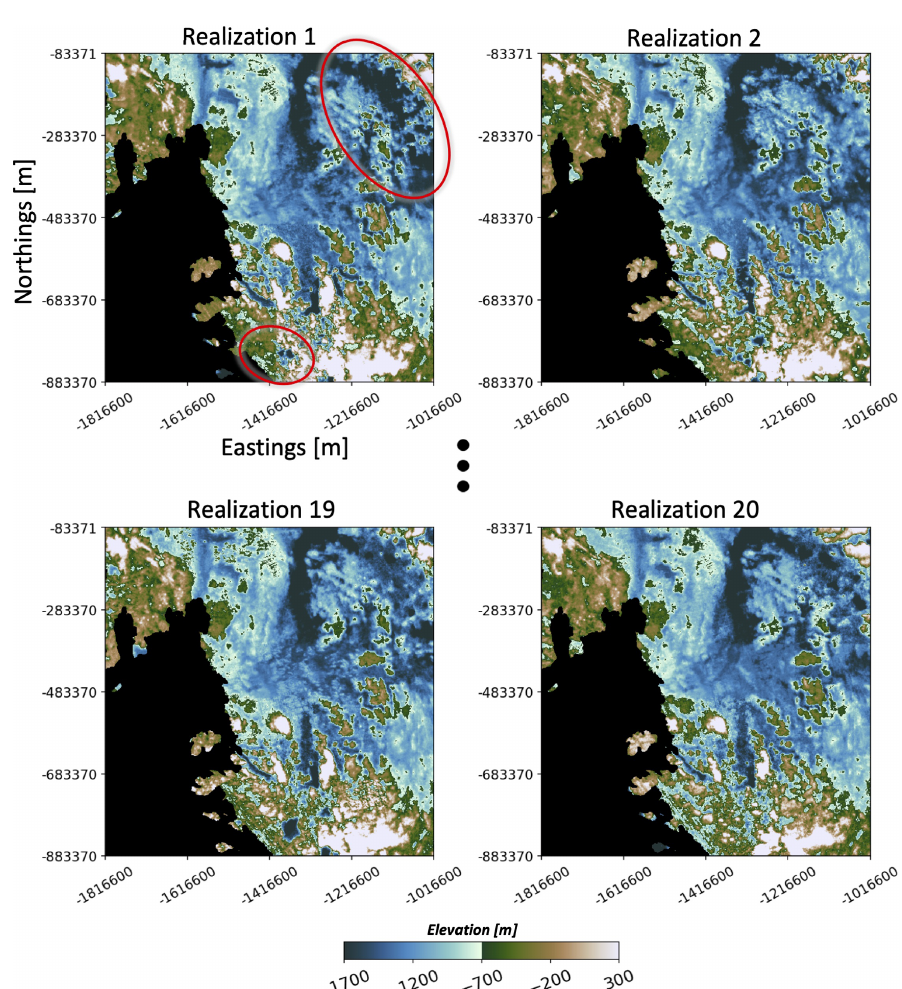
Figure 18. Realizations of the ASE topography after filling the radar line gaps. The ovals highlight the areas with high spatial variations across the realizations. The black area is the non-study area with no radar